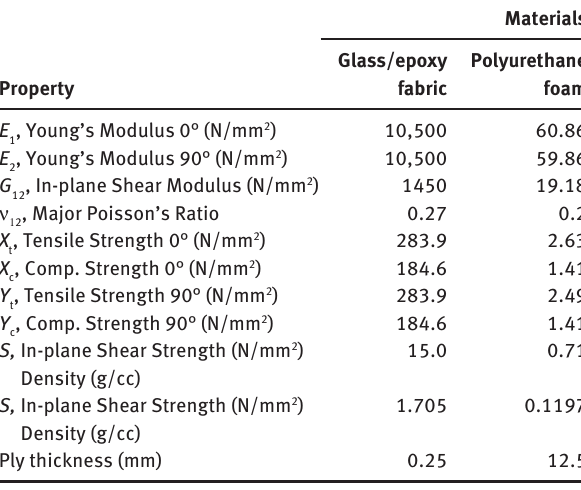
Figure 8 Structural design concept of blade with skin-spar-foam core sandwich. Table 3 Mechanical properties of materials used for blade.